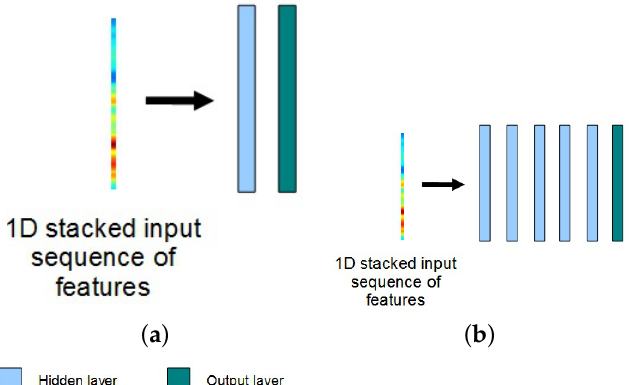
Figure 1. Proposed ANN architectures. ( a ) ANN 1 : Hidden layer #units: 12.; ( b ) ANN 2 : Hidden layer #units (from left to right): 50, 40, 30, 20, 10.